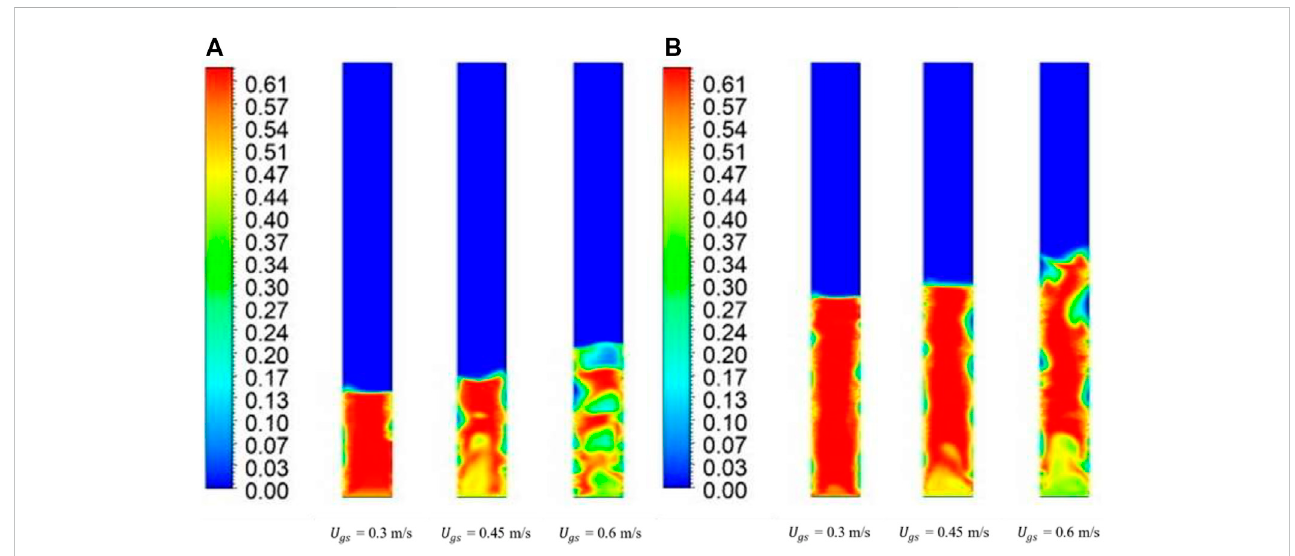
FIGURE 10 Time-averaged steady-state solid-phase volume fraction contours for 80% mixture at (A) 0.335 m bed height and (B) 0.635 m bed height.